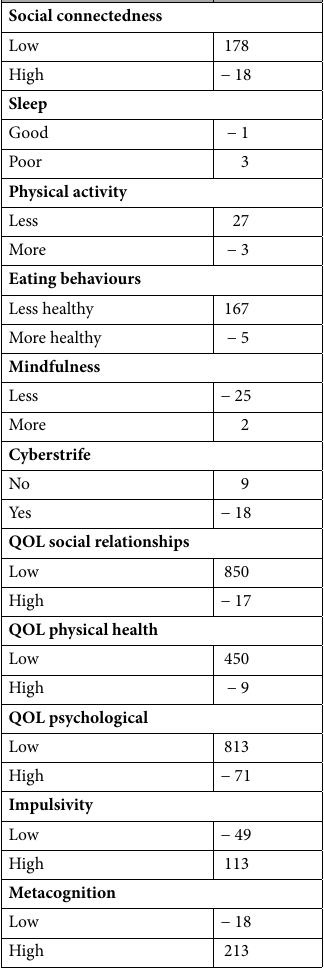
P evidence − P baseline 100%. P baseline ×